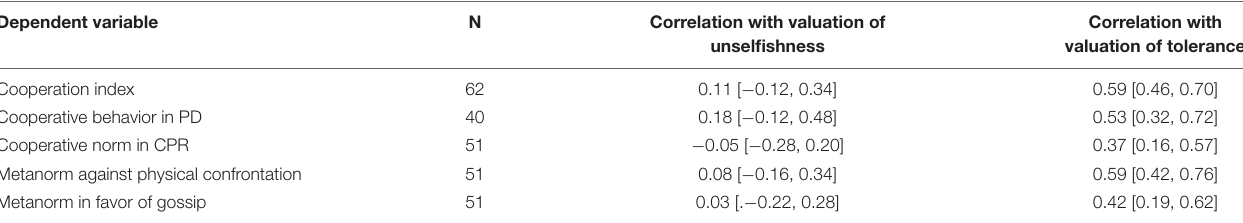
TABLE 4 | Pearson correlations between valuations of personal qualities and measures related to cooperation. Dependent variable N Correlation with valuation of